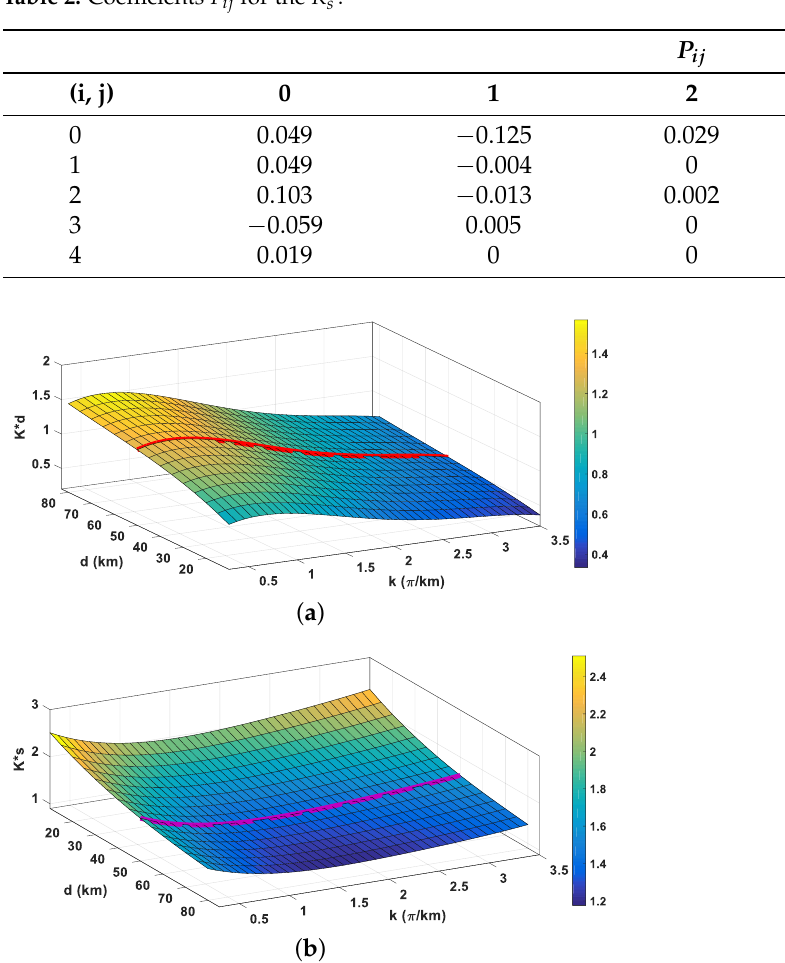
Figure 5. 3-D Graphs of the optimum adjustable factors as a function of line length and k : ( a ) K ∗ ( b ) K ∗ s